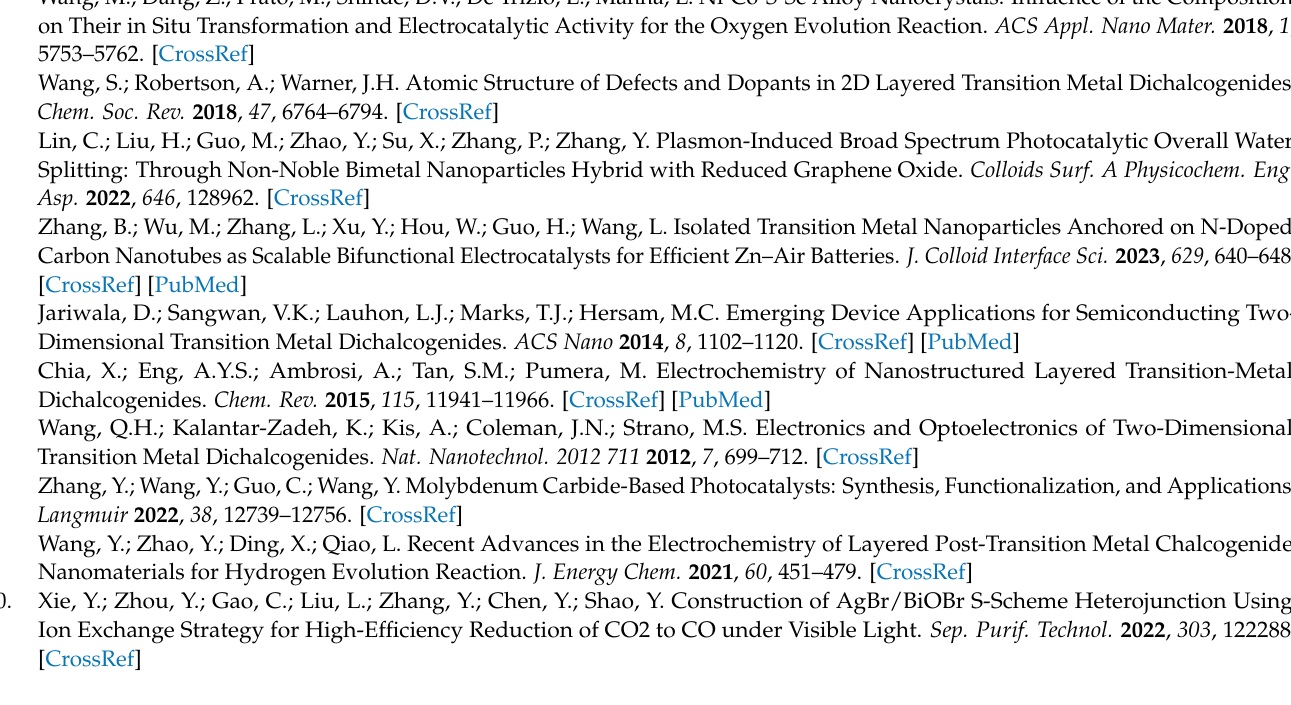
pH values; Figure S10: LSV curves (scan rate 10 mV/s) of LPE Bi 2 S 3 /SC and bulk Bi 2 S 3 (1.61 mg/cm 2 ) as HER electrocatalysts in neutral electrolyte (Na 2 SO 4 0.5 M). Table S1: Zeta potential ( ζ ), average size, band gap, concentration and yield of nano-sized LPE Bi 2 S 3 with different concentrations of SDS surfactant; Table S2: Zeta potential ( ζ ), average size, band gap, concentration and yield of nano-sized LPE Bi 2 S 3 with different concentrations of SC; Table S3: Zeta potential ( ζ ), average size, band gap, concentration and yield of nano-sized LPE Bi 2 S 3 with different concentrations of bulk Bi 2 S 3 ; Table S4: Zeta potential ( ζ ), average size, band gap, concentration and yield of nano-sized LPE Bi 2 S 3 with different exfoliation time; Table S5: Zeta potential ( ζ ), average size, band gap, concentration and yield of nano-sized LPE Bi 2 S 3 with different solvents; Table S6: Zeta potential ( ζ ), average size, band gap, concentration and yield of nano-sized LPE Bi 2 S 3 with different exfoliation methods; Table S7: Overpotential at 1 mA/cm 2 and Tafel slope referred to LPE Bi 2 S 3 /SC HER activity in neutral electrolyte; Table S8: Summary of the experimental parameters of all the exfoliations in this